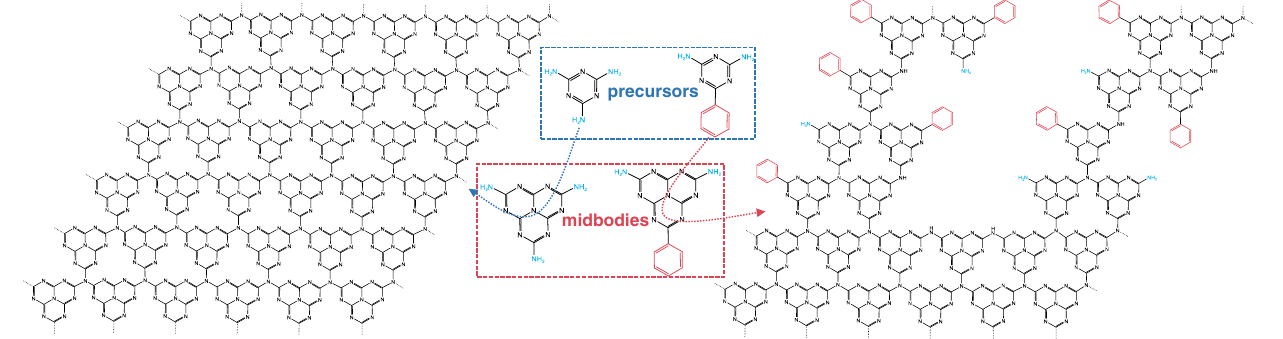
Fig. 2 | Synthesis process of g-CN materials. A schematic of p-CN and PhCN prepared via the one-step thermal polymerization process from the precursor.